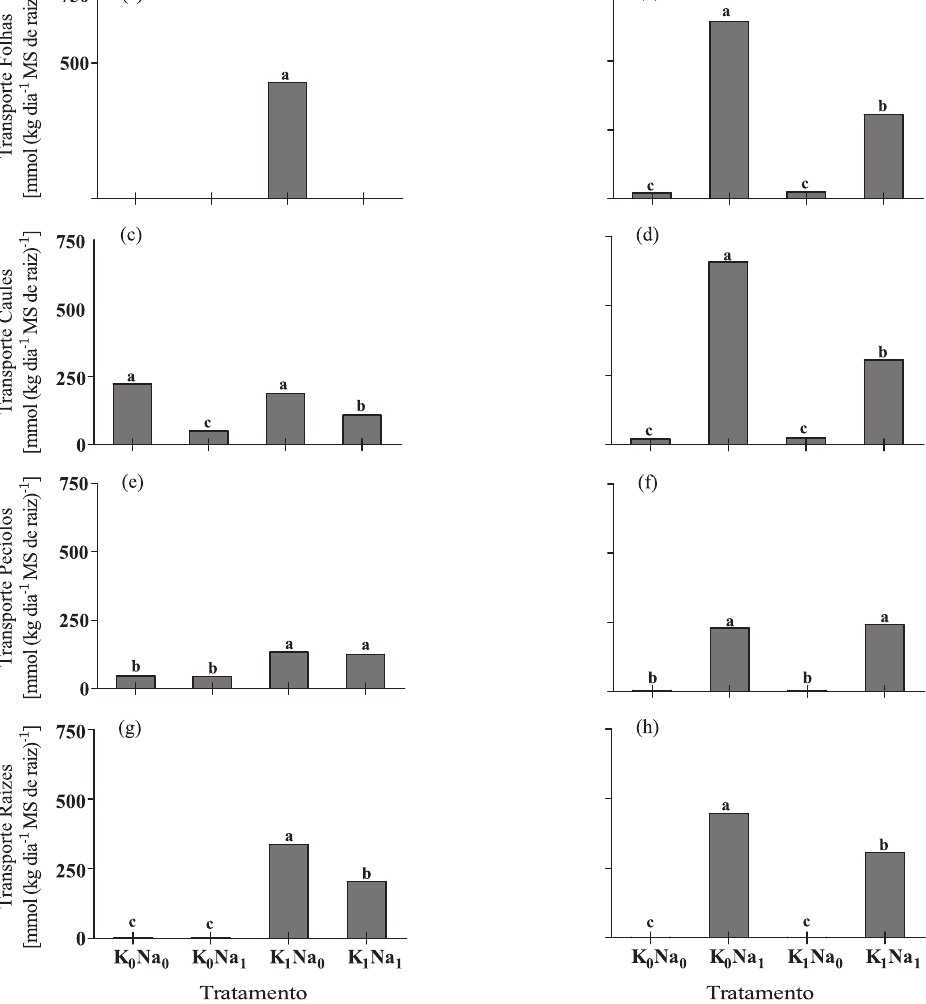
figura 2. Transporte de K e na em (a,b) folhas, (c,d) caule, (e,f) pecíolos e (g,h) raízes, respectivamente em plantas de pinhão-manso submetidas a diferentes concentrações externas de K e na por um período de oito dias. K 0 : ausência de potássio; K 1 : 10 mmol l -1 de K; na 0 : ausência de sódio; e na 1 : 50 mmol l -1 de na na solução nutritiva. os valores representam médias de cinco repetições. médias iguais segui- das de letras minúsculas não denotam diferenças significativas, conforme o teste de Tukey (p <